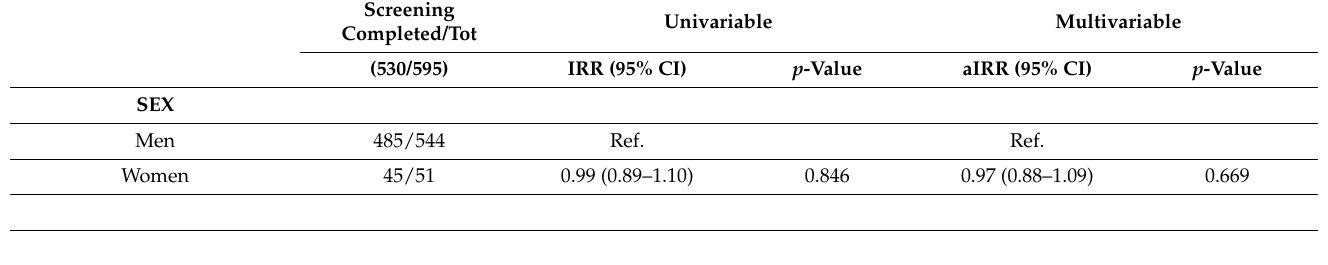
Table 2. Incidence rate ratio (IRR) and 95% con fi dence intervals (CIs) for screening completion.